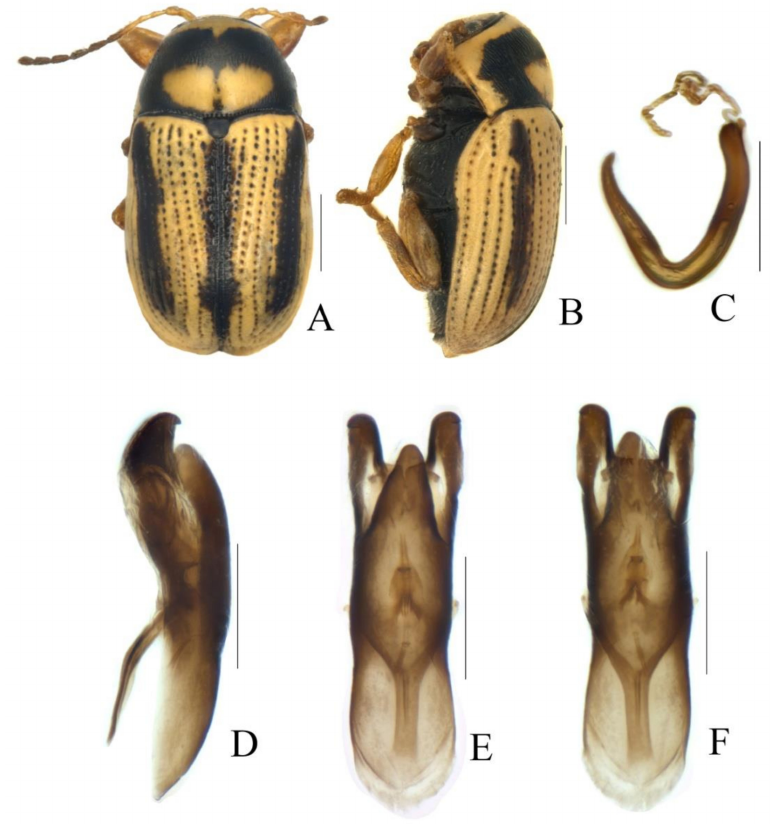
Figure 11. Cryptocephalus ( Burlinius ) bilineatus (Linnaeus, 1767): ( A ) habitus; ( B ) lateral view of habitus; ( C ) spermatheca; ( D ) lateral view of aedeagus; ( E ) dorsal view of aedeagus; ( F ) ventral view of aedeagus. (Scale bars: ( A , B ) = 0.5 mm, ( C – F ) = 0.2 mm.) (( A , B , D – F ): male; ( C ): female; both from Inner